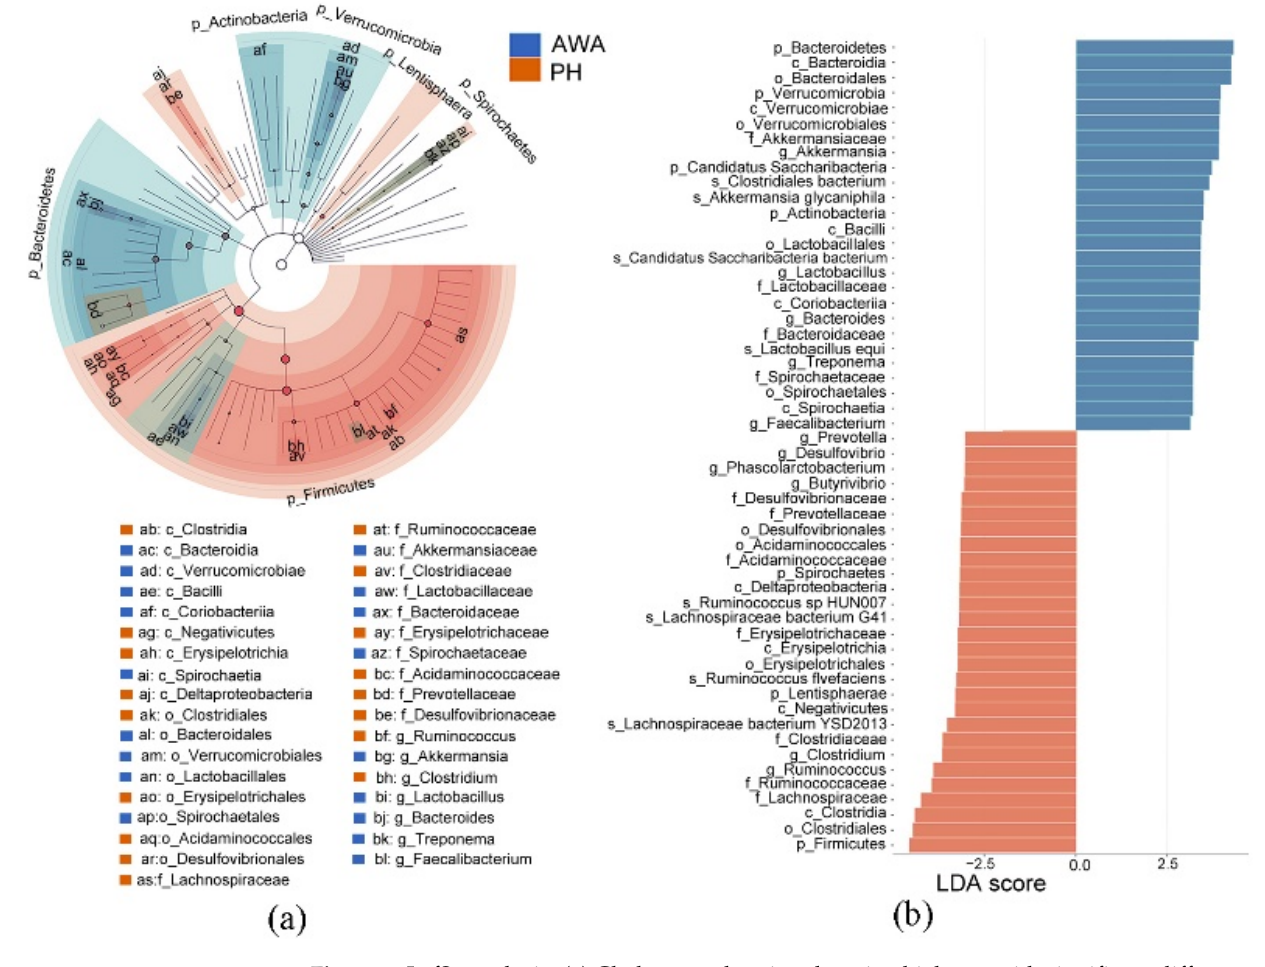
Figure 3. LefSe analysis. ( a ) Cladogram showing the microbial taxa with significant differences in abundance between Przewalski’s horses (PH) and Asiatic wild asses (AWA). Taxonomic hierarchies were arranged from the inside to the outside (from genus to phylum) in the cladogram; ( b ) Taxa with significant differences that have an LDA score > the threshold value of 3. Red and blue nodes and bars represent differentially abundant taxa between groups (red = more enriched in PH, blue = enriched in